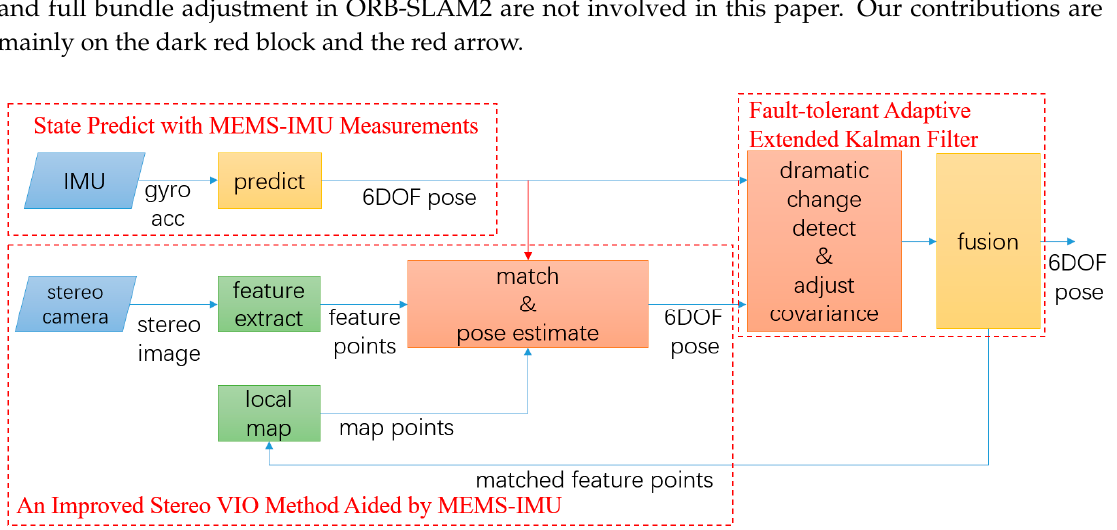
Figure 3. Framework of the proposed method. (the dark red blocks and red line are the difference between traditional VIO framework. the blue blocks represent the source from micro electro mechanical systems inertial measurement unit (MEMS-IMU) and stereo-camera. the green blocks represent traditional VO and dark yellow blocks represent MEMS-IMU measurements aided).